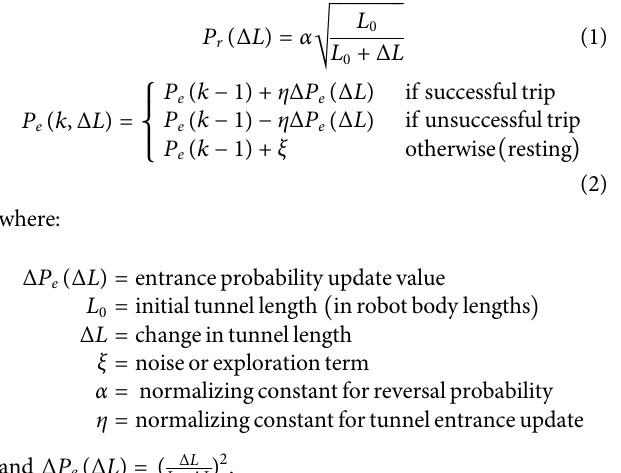
Frontiers in Physics |